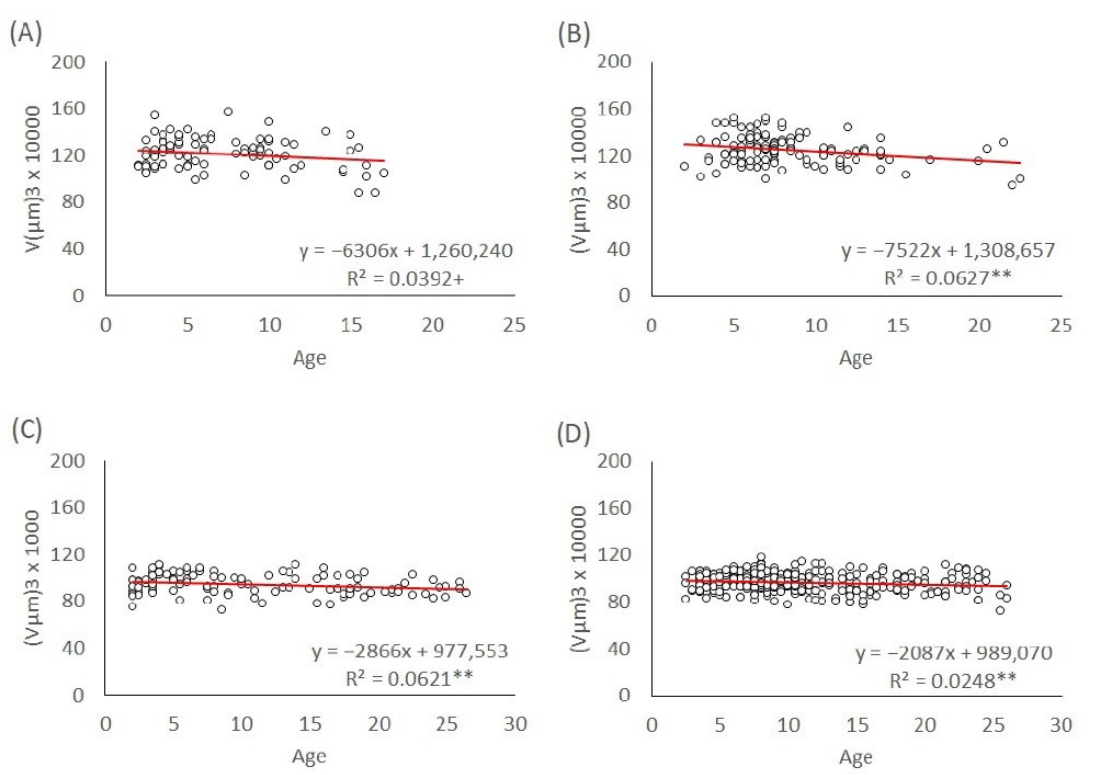
Figure 3. Linear regression of egg size throughout the lifespan of mothers. ( A ) L1 male eggs, ( B ) L1 female eggs, ( C ) T male eggs, and ( D ) T female eggs. The significance level of the slope: ** p < 0.01; + p < 0.1. Figure 4. In the case of the L1 lineage, the trends of male and female egg volumes were not significant (s = − 34,434, p = 0.91; s = 66,527, p = 0.20, respectively; see Figure 4A,B). The male and female egg volumes of the T lineage are represented in Figure 4C,D, which shows that the trends were also not significant (s = 14,635, p = 0.56; s = − 8311, p = 0.55,